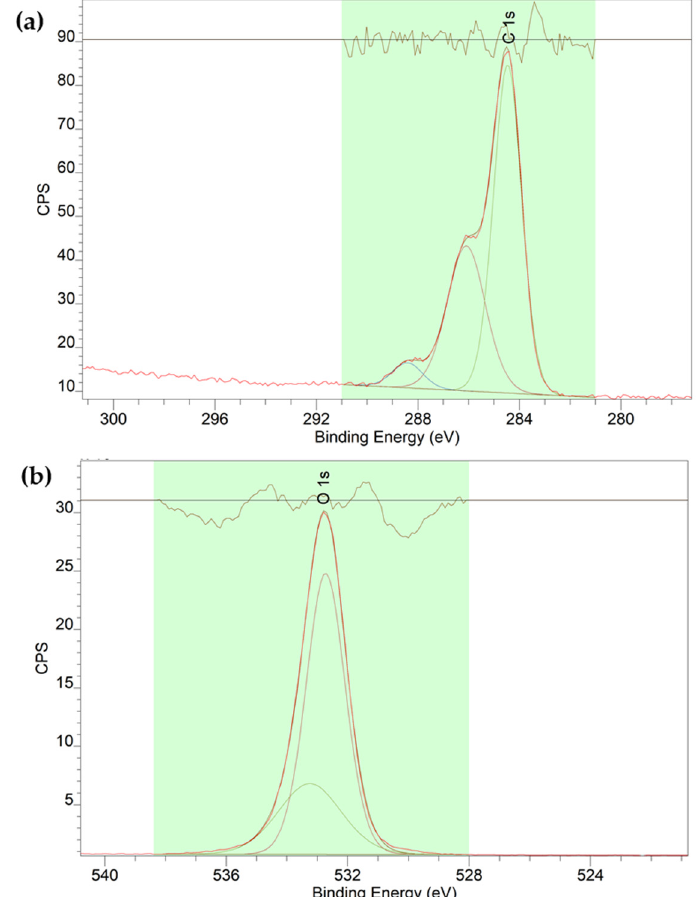
Figure 8. Deconvoluted HR-XPS spectra of the binding energies between carbon and oxygen are ascribed to ( a ) C 1 s and ( b ) O 1 s. Key functional groups of PLH and TAM molecules on the surface of MSNs are observed, including organic C=O and organic C-O.